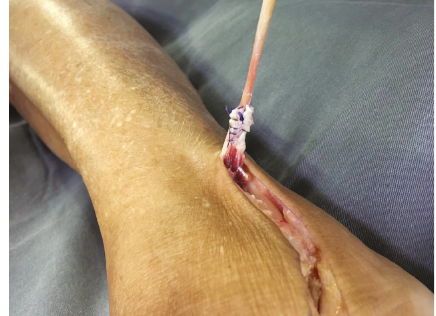
Figure 5: Patient II: the STA is secured to the proximal stump of the PB tendon with a Pulvertaft weave using a 1-0 Vicryl, 3 cm proximal to the tip of the lateral